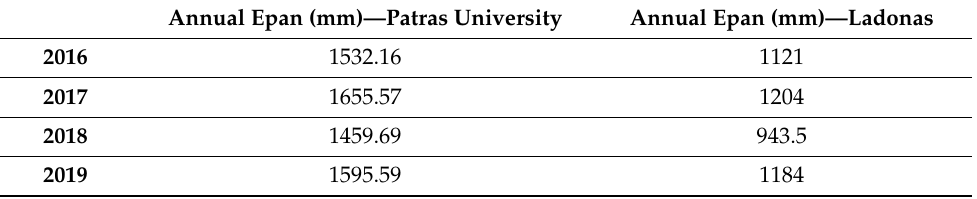
Table 3. Class A pan stations (Patras University, Ladonas): measurements of annual Epan (mm) for 2016–2019.